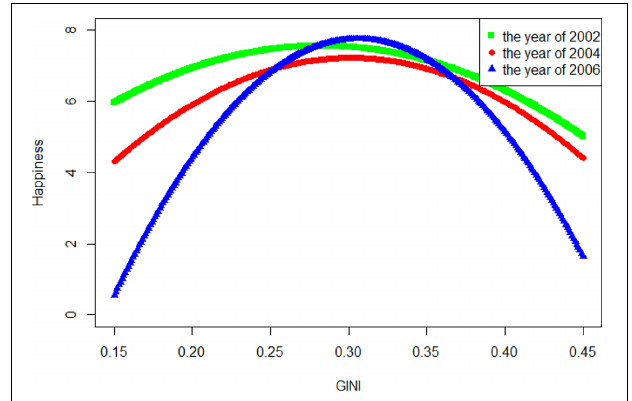
FIGURE 2 | Gini-happiness curve in Western European countries